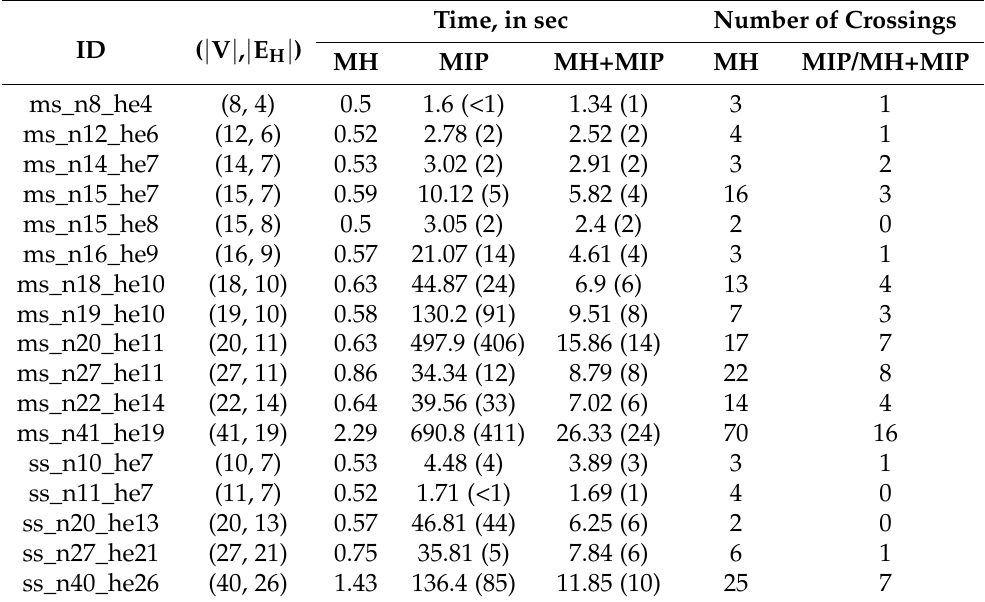
Table 1. Numerical results obtained using the mathematical heuristic (MH) and mixed-integer program (MIP) for a set of generated